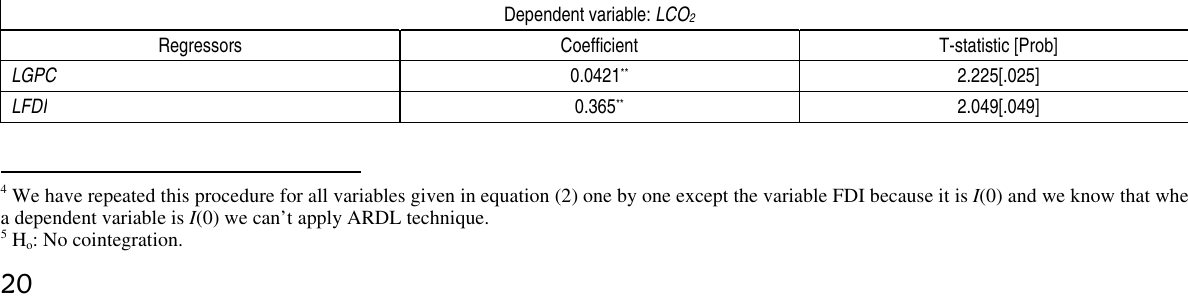
Table 4. Long-run estimates of the model